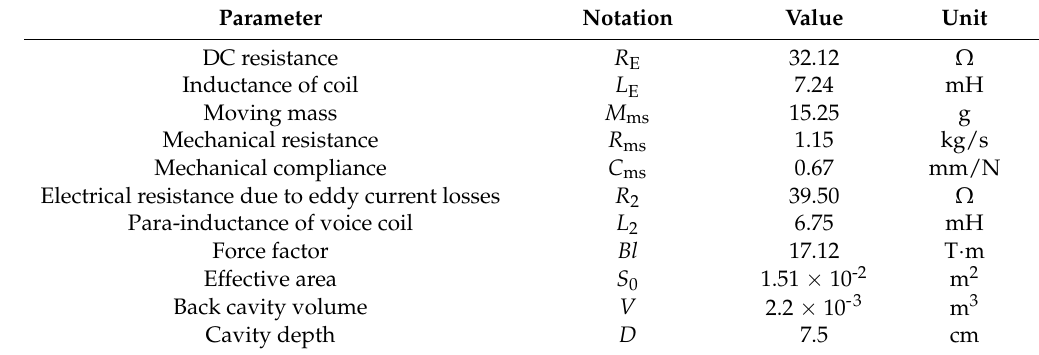
Table 3. Measured Thiele–Small (TS) parameters and dimensions of a closed-box loudspeaker (SL 1 unit).